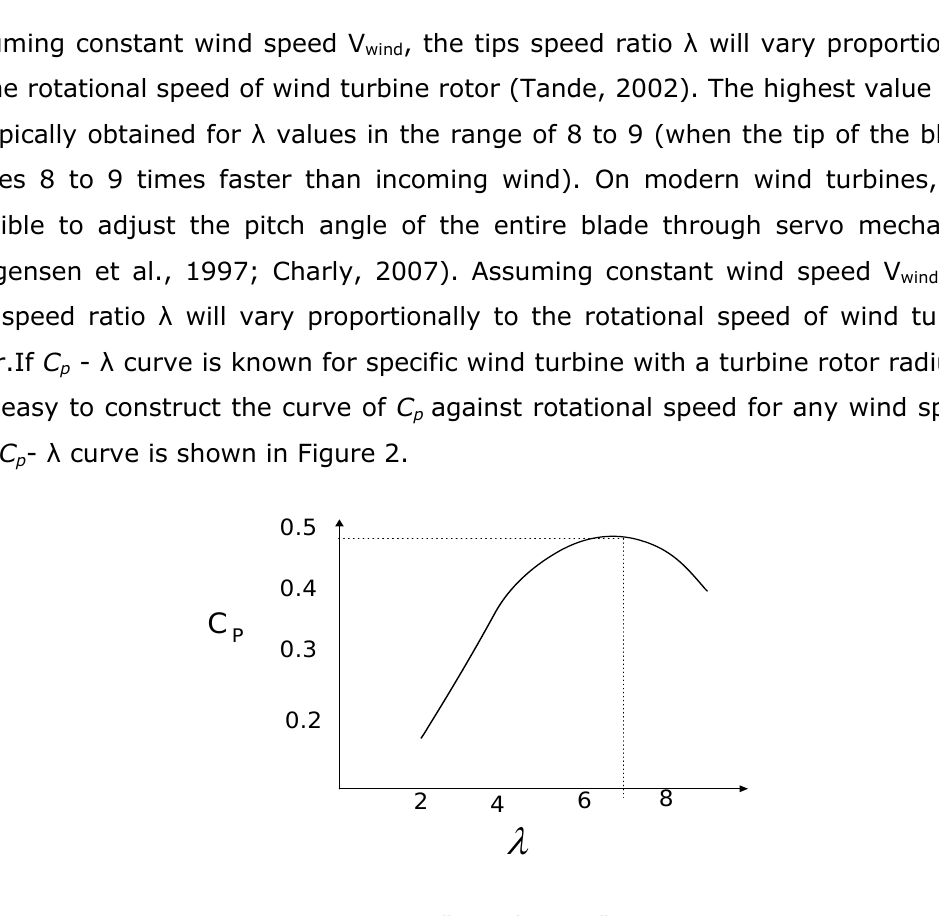
Figure 2. “Cp – λ curve”.